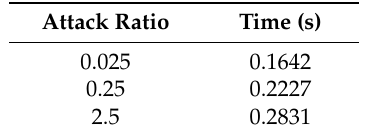
Table 8. Detection time for HMM-R in window 40 with different attack